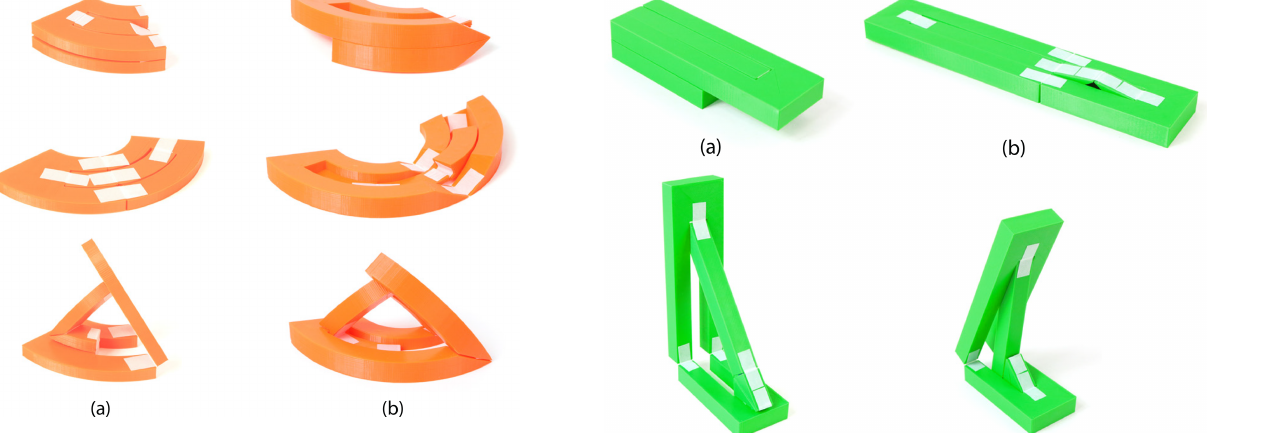
Figure 11. Flat-foldable spherical deploying strut ThUDS; (a) a simple example and (b) a more complex example with surface con- tact. Shown in flat-folded, flat, and deployed states.